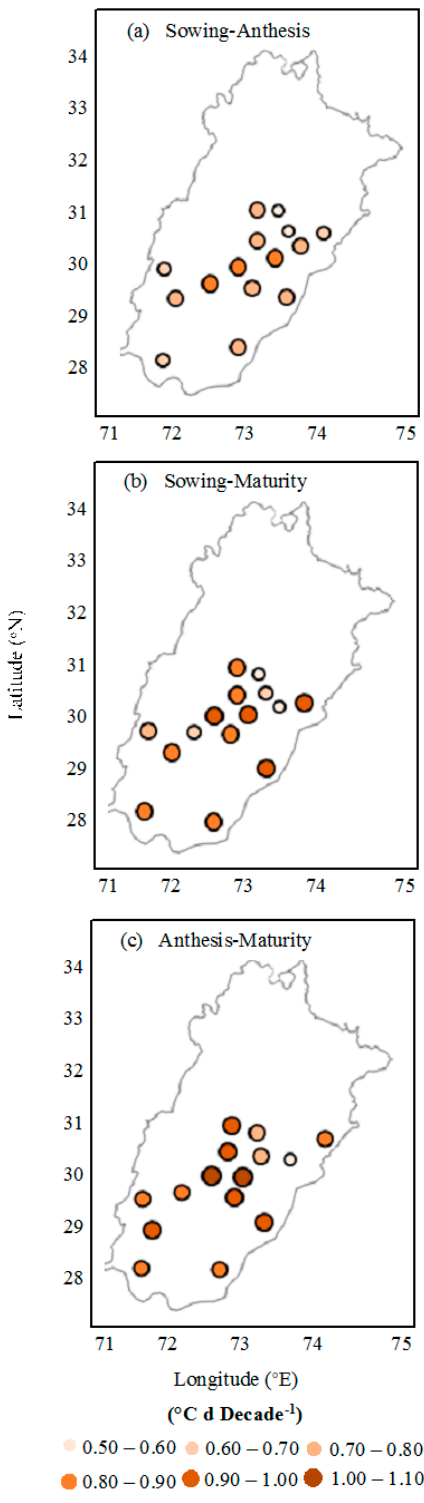
Figure 2. Observed trends in mean temperature during the phenological phases, ( a ) sowing − anthesis, ( b ) sowing − maturity and ( c ) anthesis − maturity, for cotton from 1980 to 2015 at 15 locations in Punjab, Pakistan.